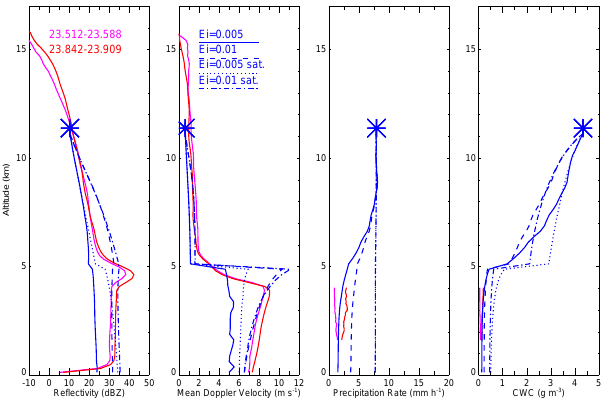
Figure 11. Profiles of reflectivity, mean Doppler velocity (positive downward), precipitation rate (liquid equivalent), and condensed water content (CWC) observed by the S-band profiler or retrieved from S-band, UHF, and VHF radars during the stratiform periods identified in Fig. 8 (pink and red) are compared with steady-state column model results initialized with size distributions measured during Airbus test flights at 11–11.5km over Darwin (blue). Sim- ulations use ice–ice sticking efficiencies of 0.01 or 0.005, and the baseline sounding or a saturated sounding (see